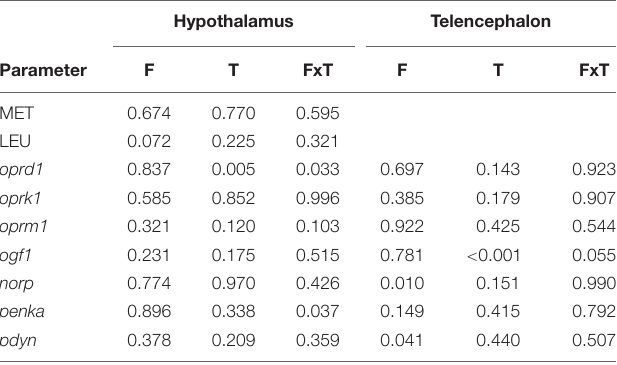
TABLE 2 | p -values obtained after two-way analysis of variance in experiment 1 of levels of opioids in hypothalamus, and mRNA abundance of transcripts related to the opioid system in hypothalamus and telencephalon of rainbow